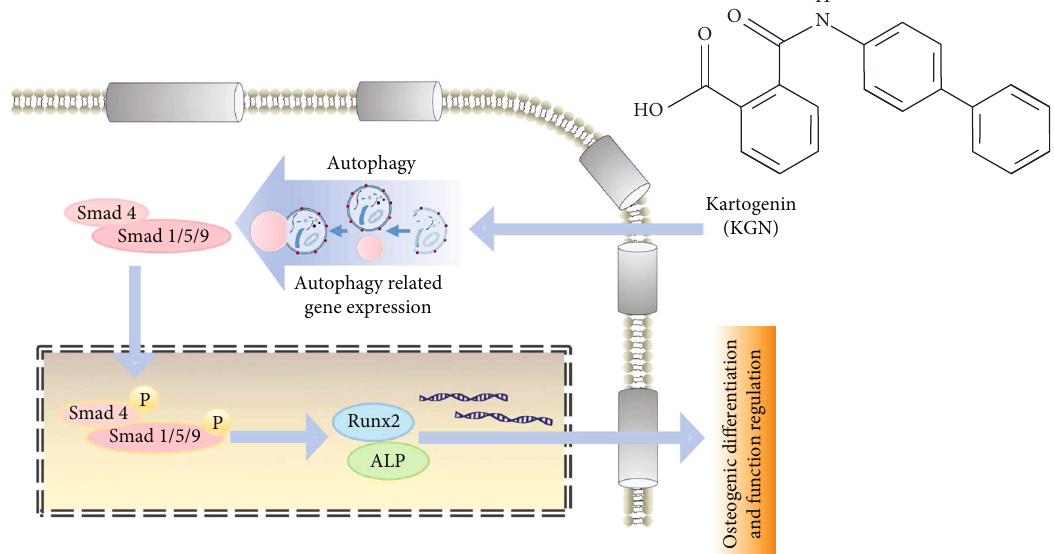
Figure 6: Schematic diagram of the study. KGN promotes autophagic activity of BMMSCs and upregulates the phosphorylation level of Smad1/5/9, thereby enhancing osteogenesis of